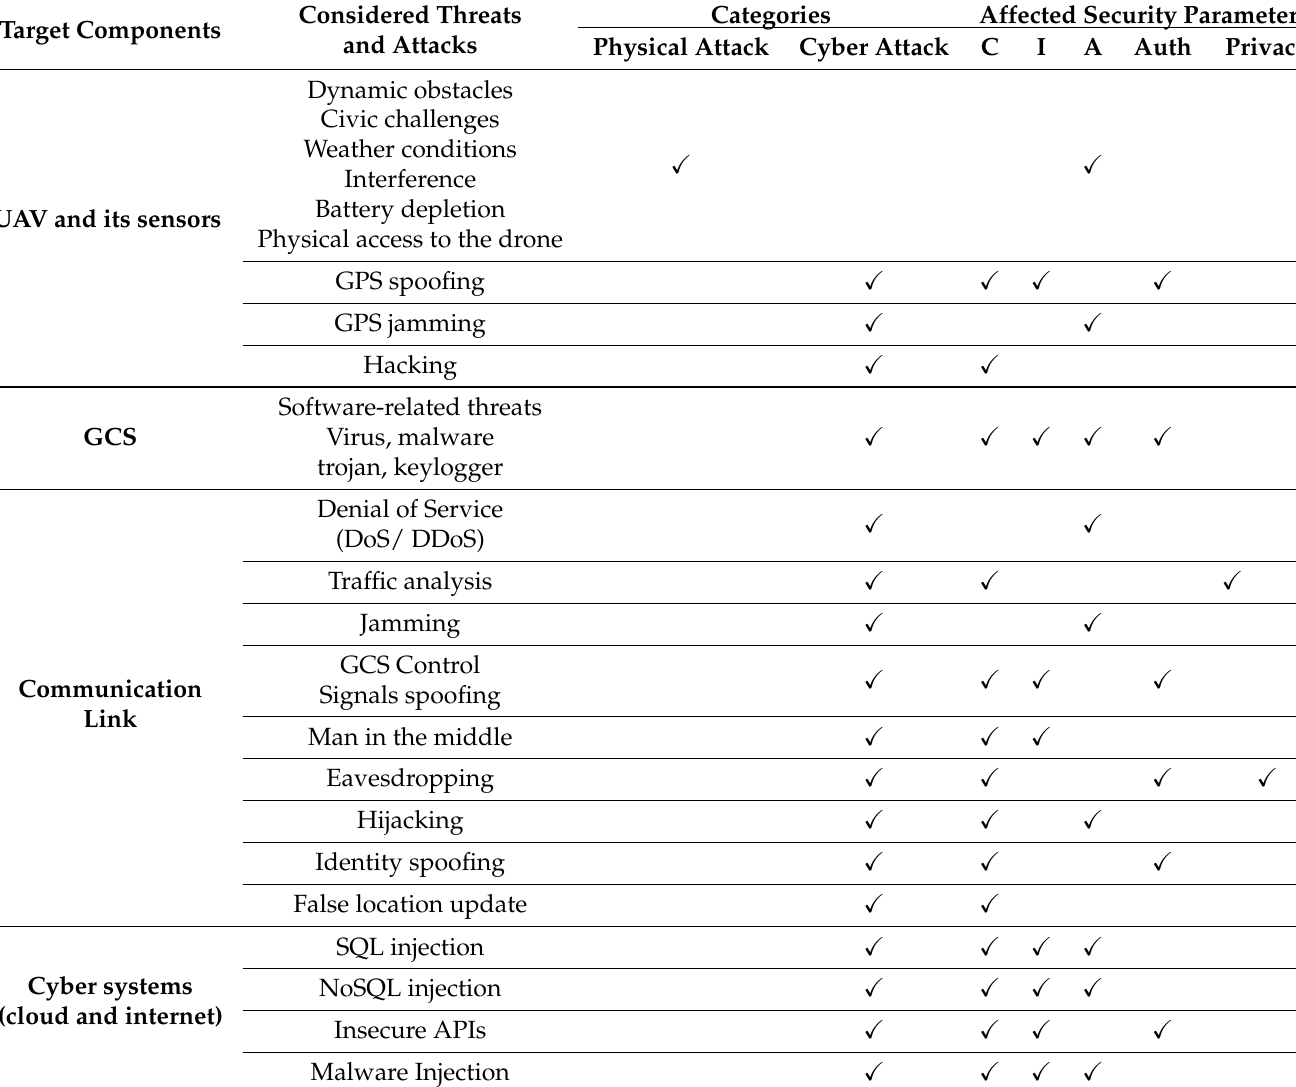
Table 2. Threats and vulnerabilities associated with the Unmanned Traffic Management system